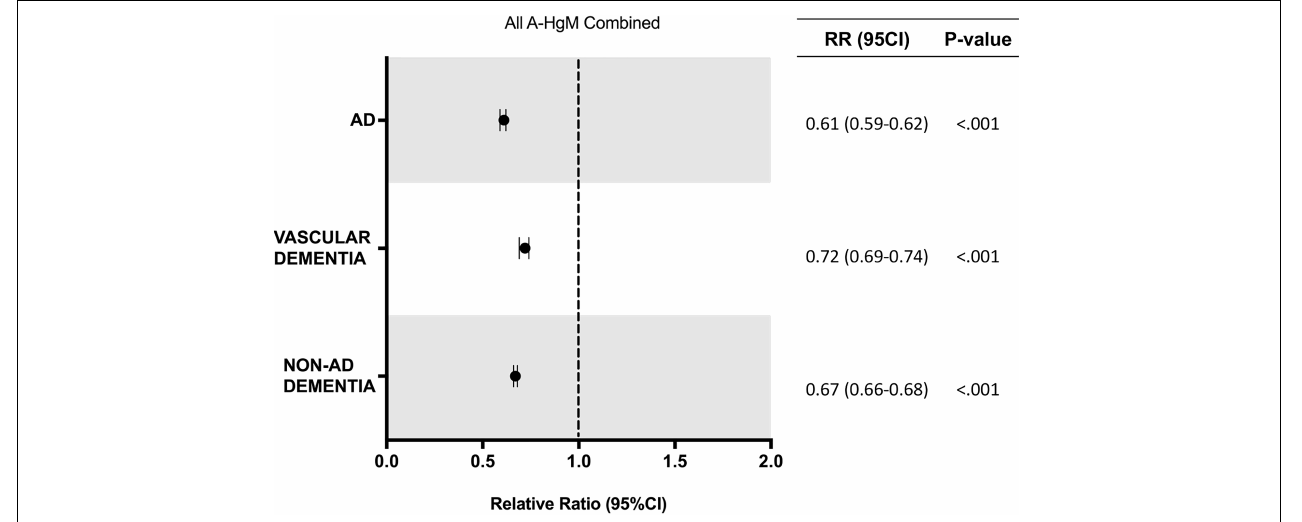
FIGURE 2 | Relative risk of developing AD and ADRD for T2D patients with exposure to anti-hyperglycemic medication. AD, Alzheimer’s disease; RR, relative risk; CI, confidence interval.